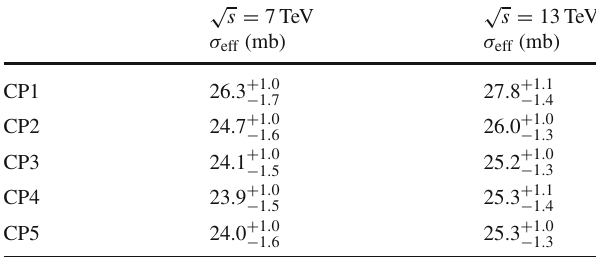
√ s = 7 and 13TeV obtained with the new